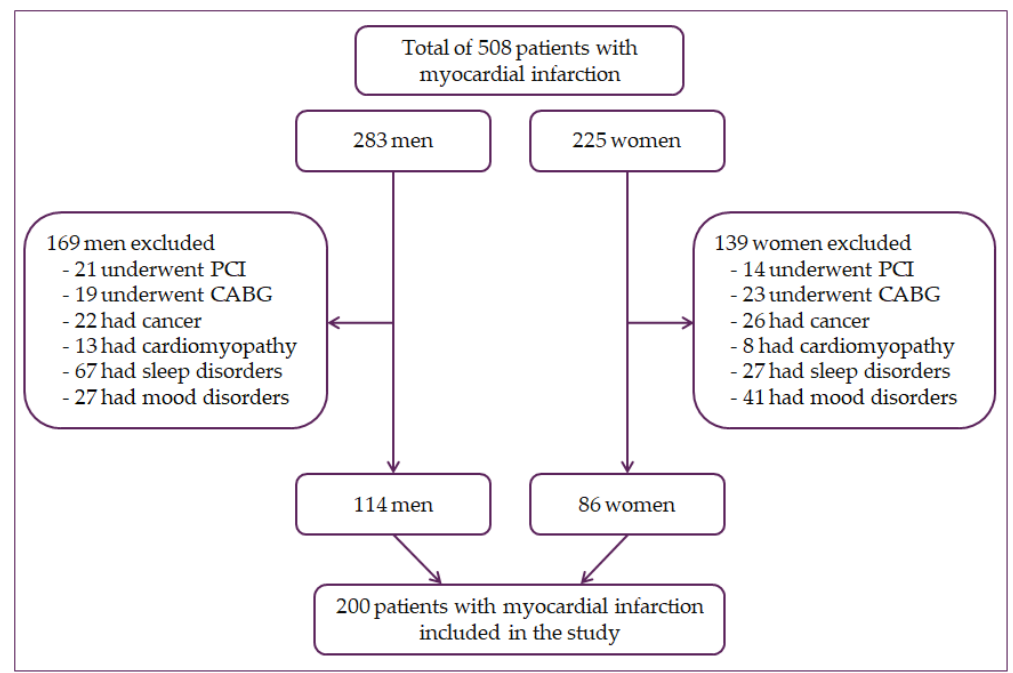
Figure 1. Flowchart of patient selection. PCI—percutaneous coronary intervention, CABG—coronary artery bypass grafting.